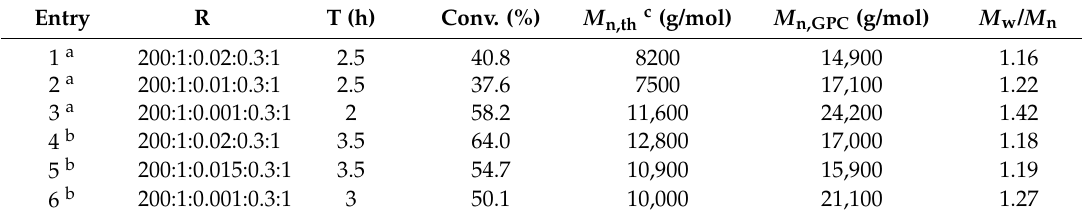
Table 2. Effect of type of azo-initiators on ICAR ATRP of